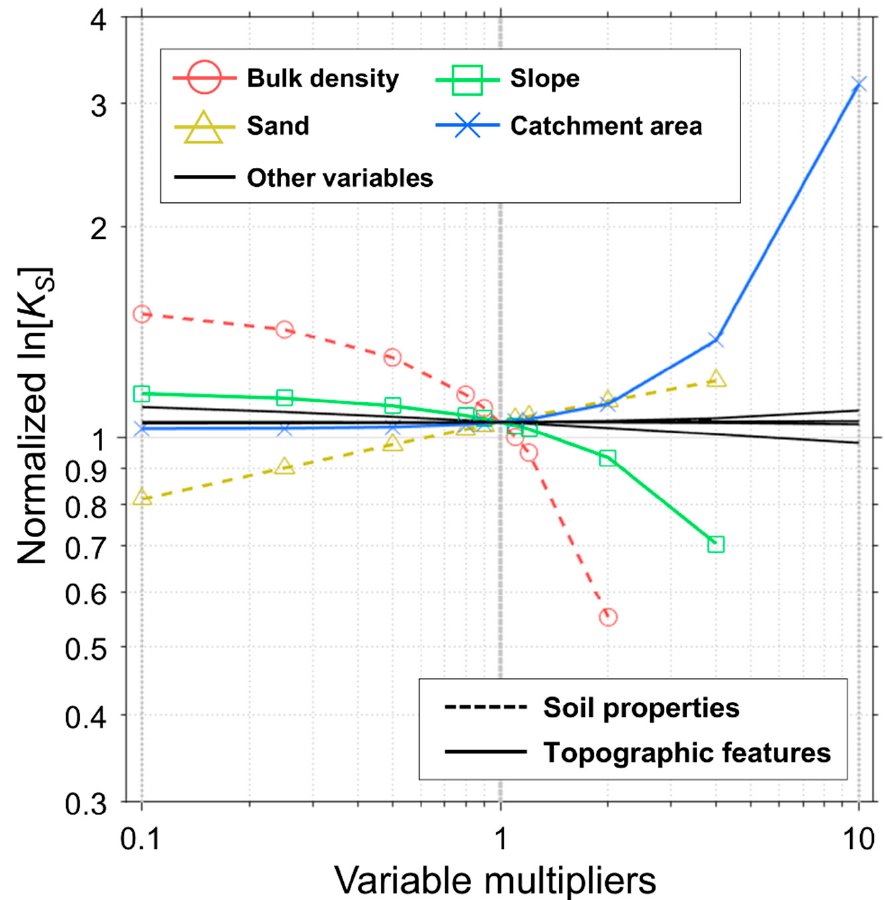
Figure 5. Sensitivity results for logarithmized K s . Only the four most sensitive variables are colored, and the variables of soil properties are shown with dashed lines. Large vertical differences from the line y = 1 indicate a relatively high sensitivity for estimating the saturated hydraulic conductivity.